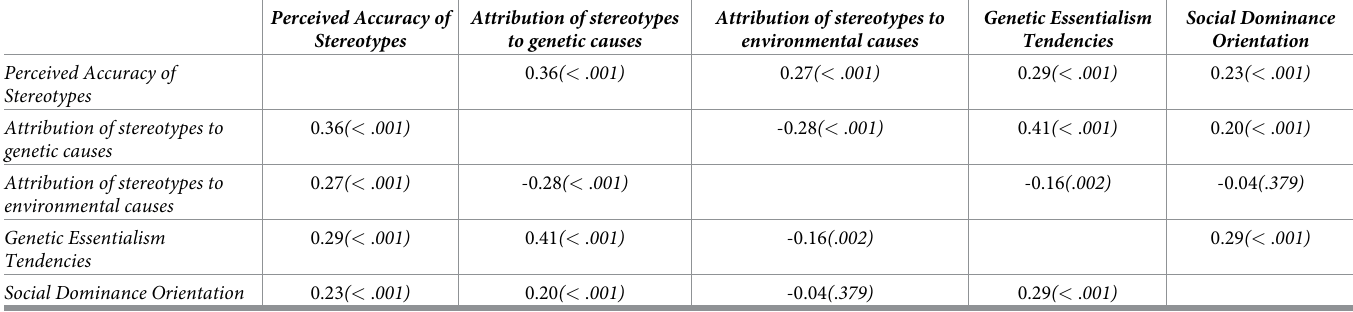
Perceived Accuracy of Attribution of stereotypes Attribution of stereotypes to Genetic Essentialism Social Dominance Stereotypes to genetic causes environmental causes Tendencies